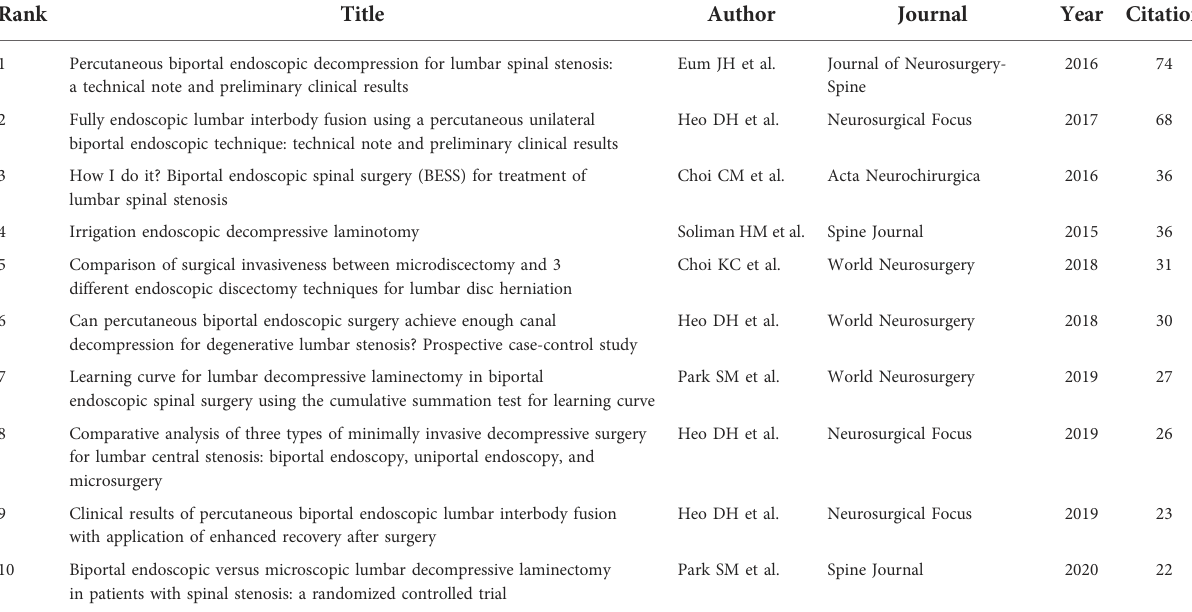
TABLE 5 Top 10 cited articles in the fi eld of unilateral biportal endoscopic spine surgery.